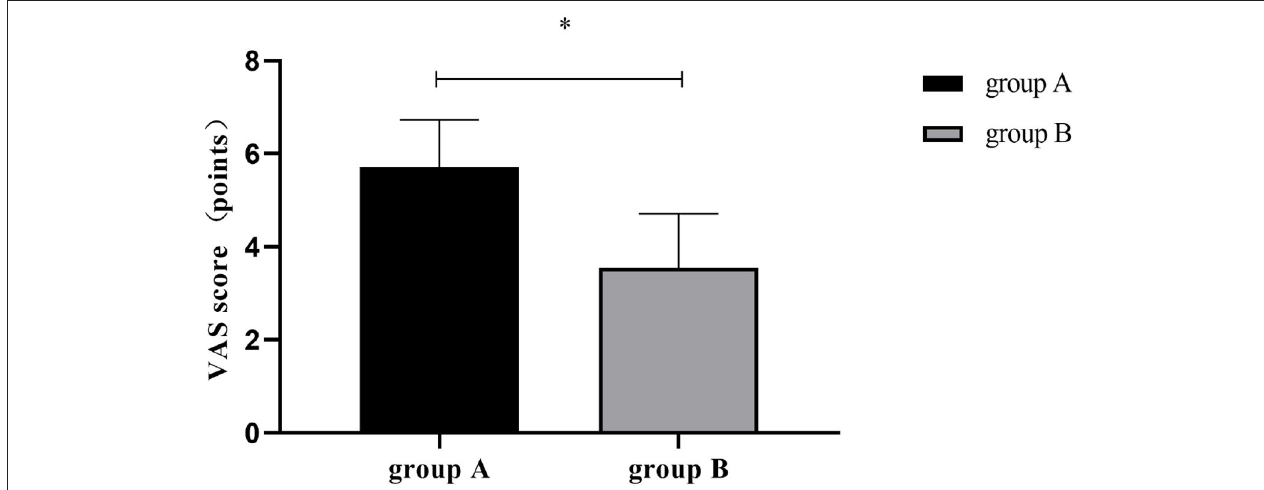
FIGURE 3 | Postoperative VAS scores [Mean ± SD]. The horizontal axis denoted groups A and B, and the vertical axis denoted the VAS score (points); After surgery, the VAS scores of groups A and B were respectively (5.71 ± 1.02) and (3.55 ± 1.16); and *indicated a significant between-group difference in postoperative VAS scores (t = 9.789, P < 0.001).